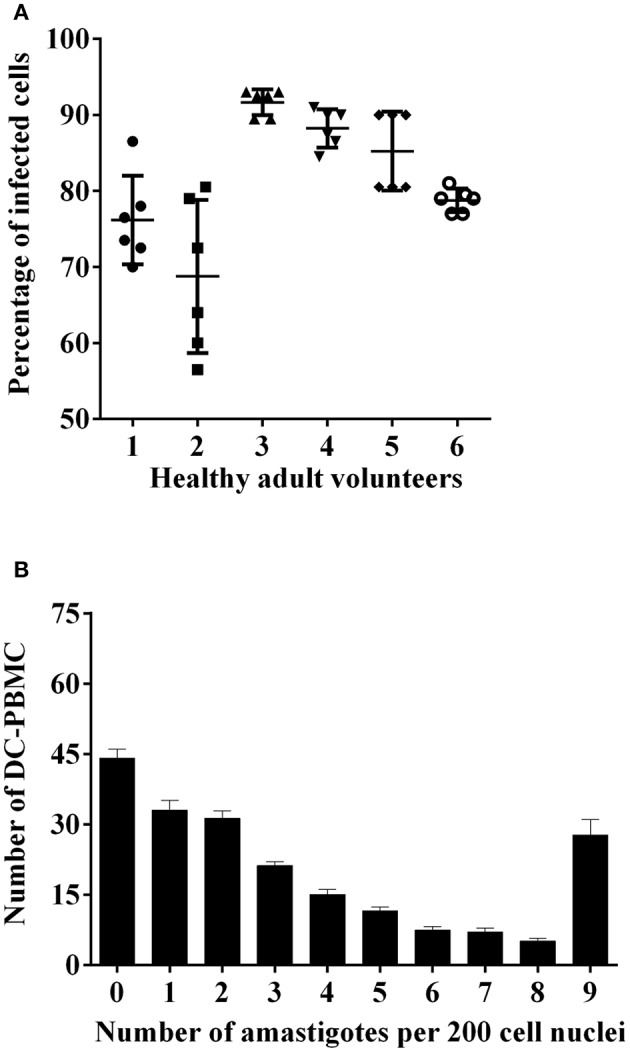
T. cruzi-infected DC-PBMC. DC-PBMC presented different susceptibilities to T. cruzi infection. DC-PBMC were incubated with T. cruzi trypomastigotes at parasite-to-cell ratio (5:1). After 18 h, the cultures were washed to remove free parasites and DC-PBMC were fixed with methanol and stained with Giemsa stain. Percentages of infected DC-PBMC (A) and mean numbers of amastigotes per infected DC-PBMC (B) were recorded after microscopy examination of at least 200 cells. Results are the mean ± standard error for six independent experiments with six different blood donors.